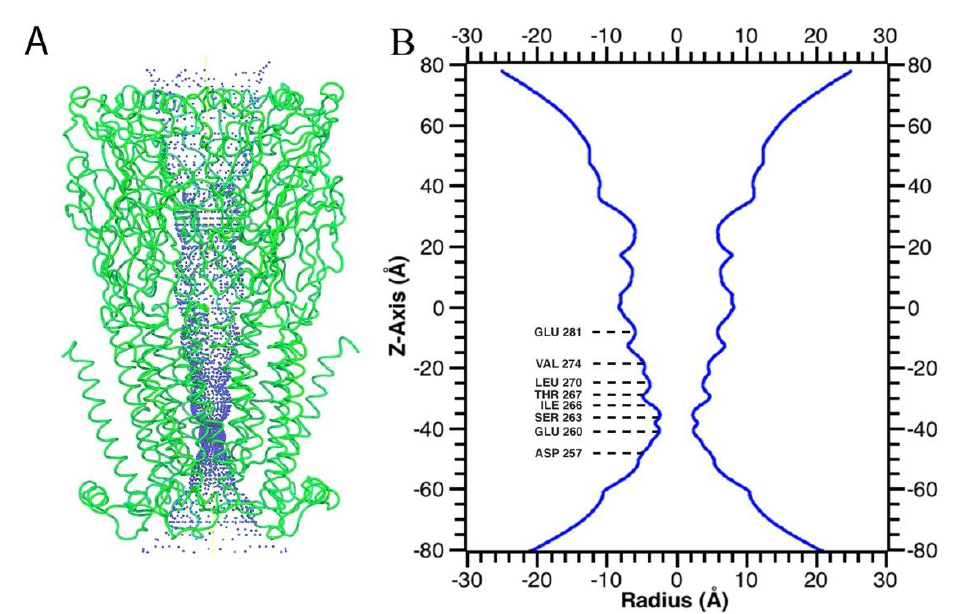
Figure 4. The narrowest central region of the ion channel illustrates residues directed toward the channel lumen. ( A ) α 7 nAChR receptor pore domain highlighting the pore size in blue. ( B ) Pore radius of the receptor. Lines indicate the residues facing the ion channel.